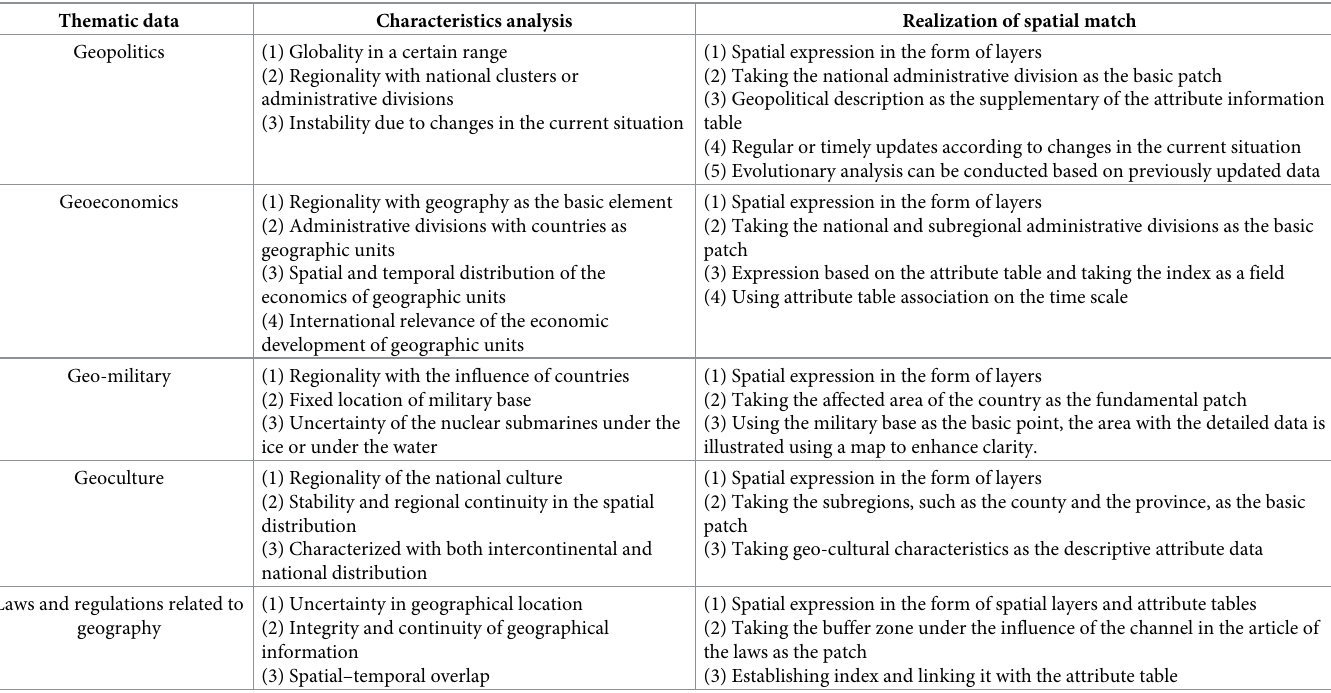
Table 1. Basic scheme for geopolitical environmental spatial